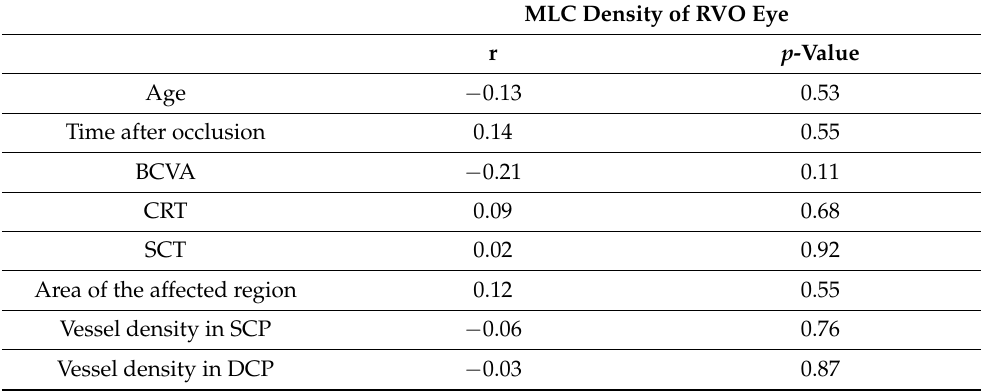
BCVA, best-corrected visual acuity; CRT, central retinal thickness; DCP, deep capillary plexus; MLC, macrophage-like cells; RVO, retinal vein occlusion; SCP, superficial capillary plexus; SCT, subfoveal choroidal thickness.